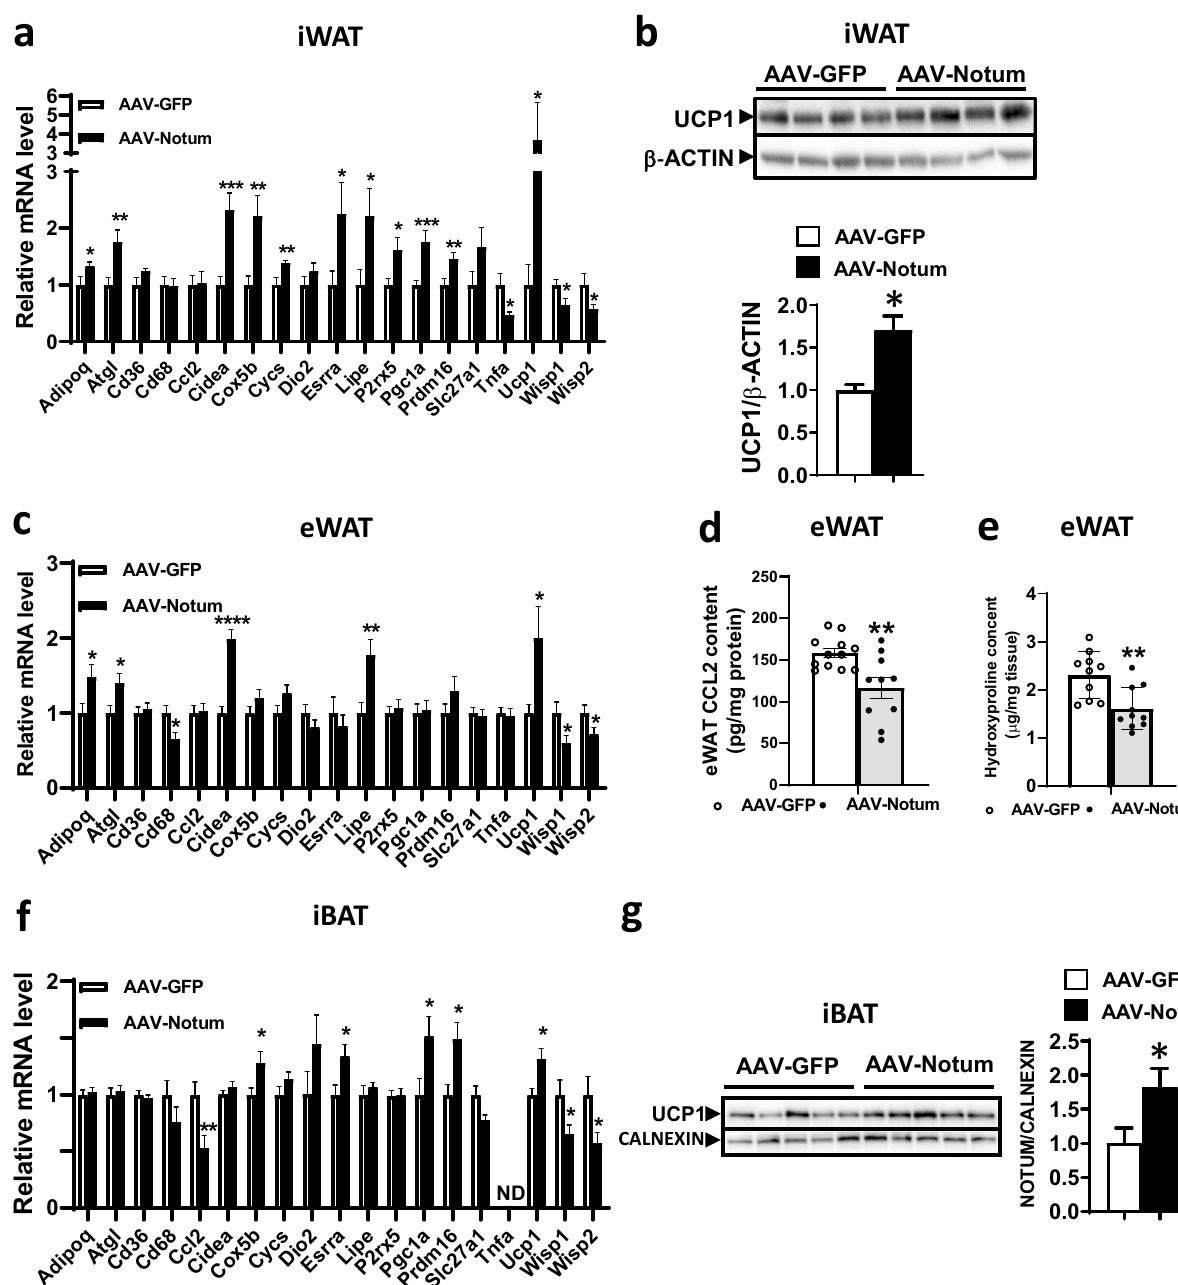
Figure 4. NOTUM overexpression promotes thermogenic capacity in WATs and iBAT and decreases adipose tissue inflammation and fibrosis. IWAT, eWAT, and iBAT samples from the same mice described in Fig. 1a–i were used for the following assays. ( a ) Gene expression analysis by qPCR of iWATs are shown. n = 9–12/ group. ( b ) Protein levels of UCP1 and β-ACTIN in the iWAT were determined by immunoblotting (top) and quantification of the UCP1 protein normalized by the β-ACTIN protein is shown at the bottom. n = 4. Images of UCP1 and β-ACTIN were obtained from different parts of same blot. Gene expression analysis by qPCR, ( c ), CCL2 protein content, ( d ), and hydroxyproline content, ( e ), of eWAT are shown. Gene expression analysis (n = 10–12), ( f ), and UCP1 and β-ACTIN protein levels as determined by immunoblotting, ( g ), (n = 5) of iBAT are shown. Images of UCP1 and β-ACTIN were obtained from different parts of same blot. Symbols: #: p ≤ 0.09, *: p < 0.05, **: p < 0.01, ***: p < 0.001, AAV-GFP versus AAV-Notum, as determined by Student’s